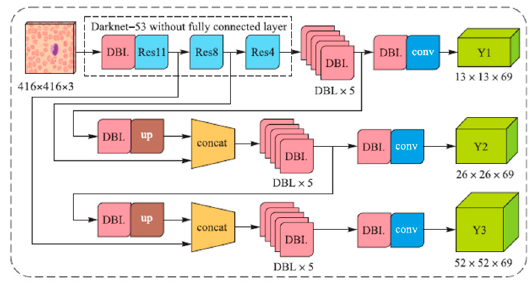
Figure 4. Structure of the YOLOv3 network. (https: // plos.figshare.com / articles / YOLOv3_architecture_ / 8322632 / 1).